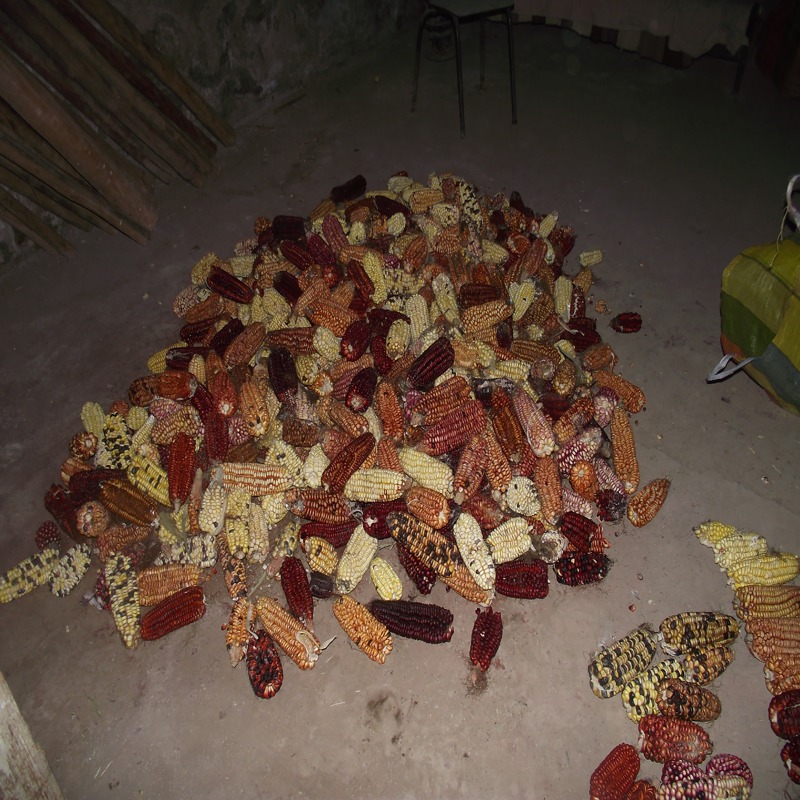
Several ears of Chulpi, Harinoso Tarapaqueño and Capio Chileno from Camiña valley.